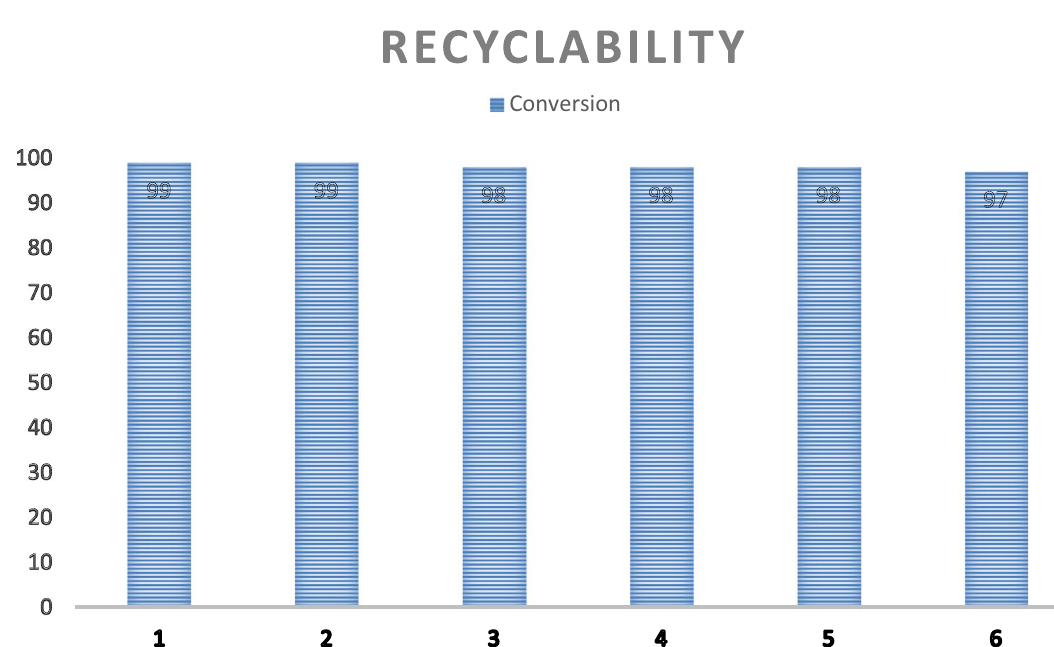
Fig. 11 Recyclability of the catalyst (C2R: 2.0 × 10 −4 mol L −1 ; H